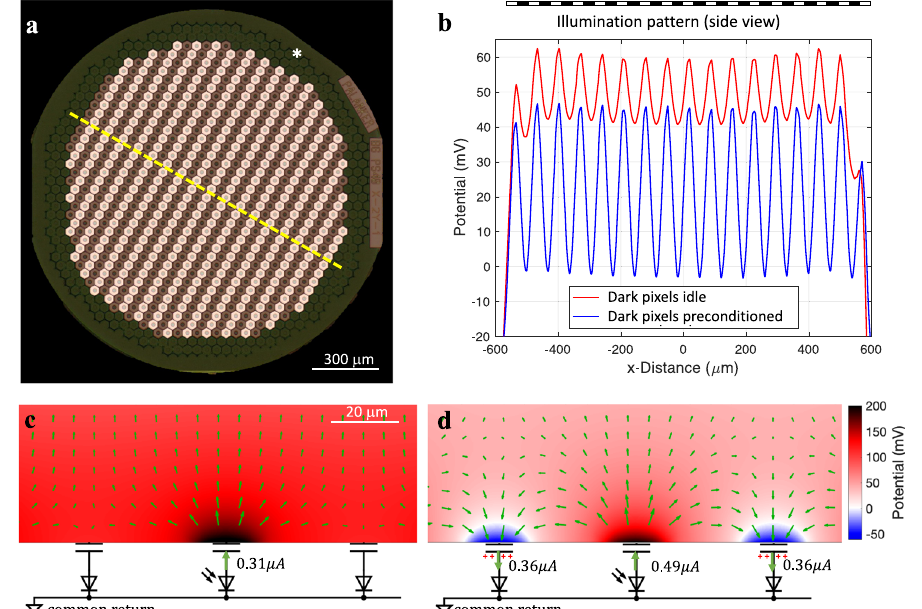
Fig. 3 | Modeling the effect of preconditioning the dark pixels. Electric fi eld in electrolyte generated by the grating pattern with and without preconditioning of thedarkpixels. a Photovoltaicarrayof1.5mmindiametercomposedofmonopolar pixels of 40 μ m width, with a common return electrode (indicated by *) along the edge of the implant. b Electric potential in electrolyte 10 μ m above the implant relative to the middle of IPL (57 μ m), plotted along the dash line shown in a , when